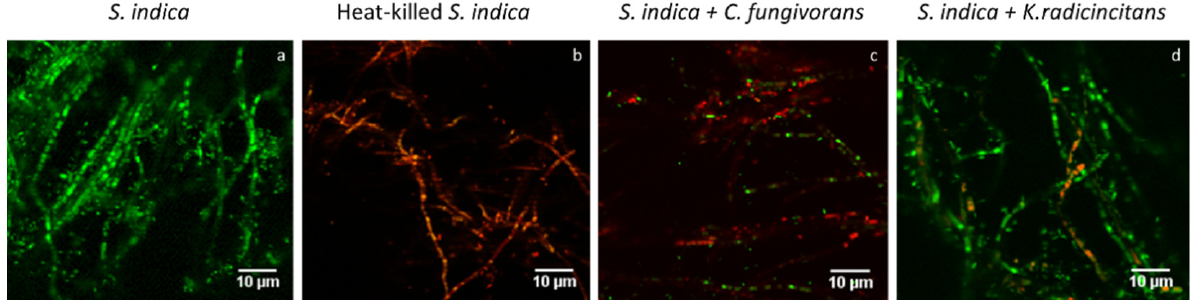
Figure 7. Imaging of microcolonies of S. indica co-cultured with K. radicincitans or C. fungivorans for 72 h at 24 °C. The samples were dual-stained with propidium iodide (red) and Syto9 (green) and observed under confocal microscope at 65× magnification. ( a ) S. indica hyphae without bacteria (control). ( b ) Heat-killed hyphae of S. indica without bacteria (control). ( c ) S. indica hyphae when co-cultured with C. fungivorans. ( d ) S. indica hyphae when co-cultured with K. radicincitans .